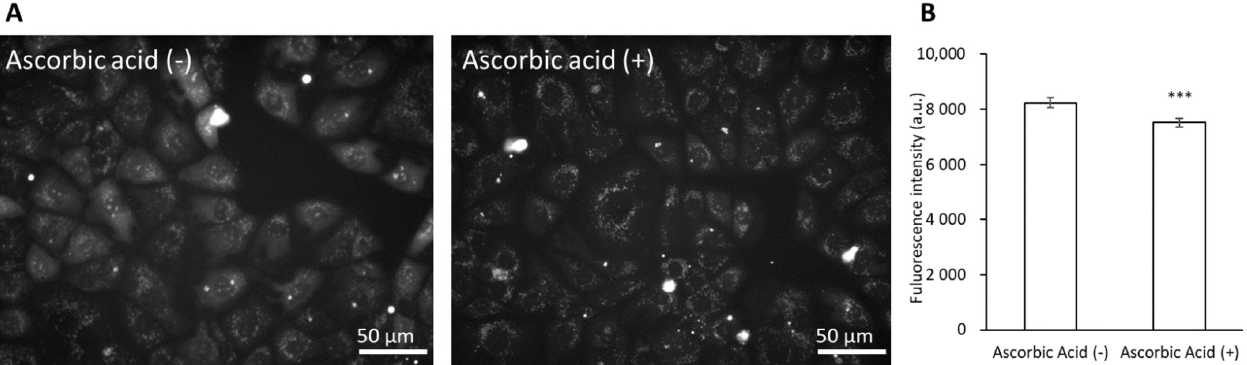
Figure 6. The fluorescence intensity of MitoSOX. The cells were incubated in a medium containing 25 μ M dabigatran etexilate with or without 500 μ M ascorbic acid. The cells were incubated for 6 h, the supernatant was aspirated, and MitoSOX was added. The fluorescence intensity of MitoSOX was measured using fluorescence microscopy. ( A ) Fluorescent microscopy utilized to assess cellular uptake of MitoSOX. ( B ) Data are expressed as means ± SD (n = 20). The sample size is the number of cells in the analyzed images. Ex = 535–555 nm and Em = 570–625 nm. *** p < 0.001.